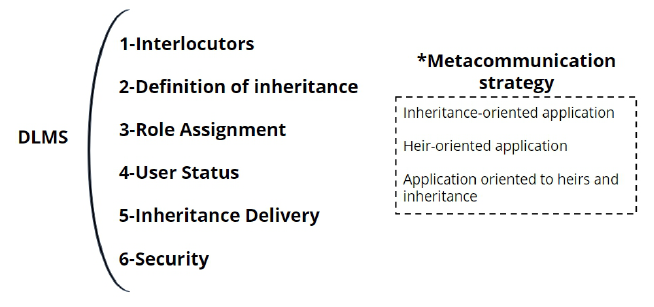
Fig. 1. DiLeMa with all its dimensions.